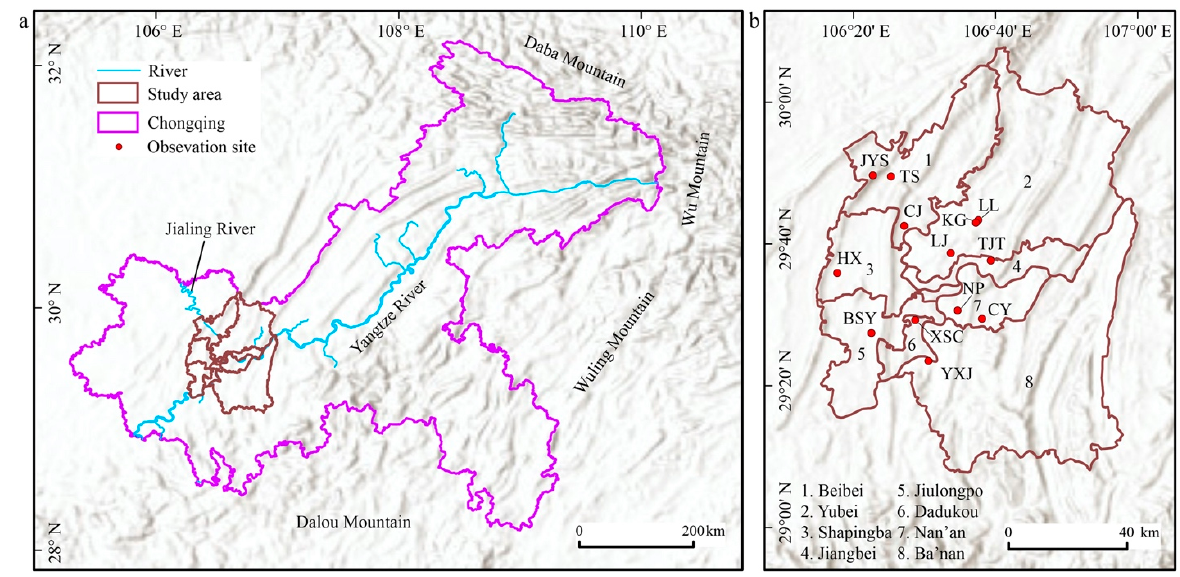
Figure 1. Location of the study area in Chongqing ( a ) and distribution of observation sites (red dots) in related counties ( b ).